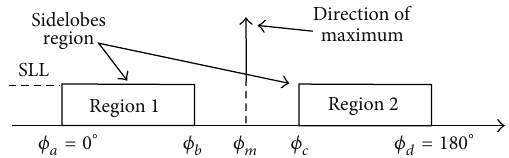
Figure 6: Mask applied for the synthesis of the switched beam arrays.